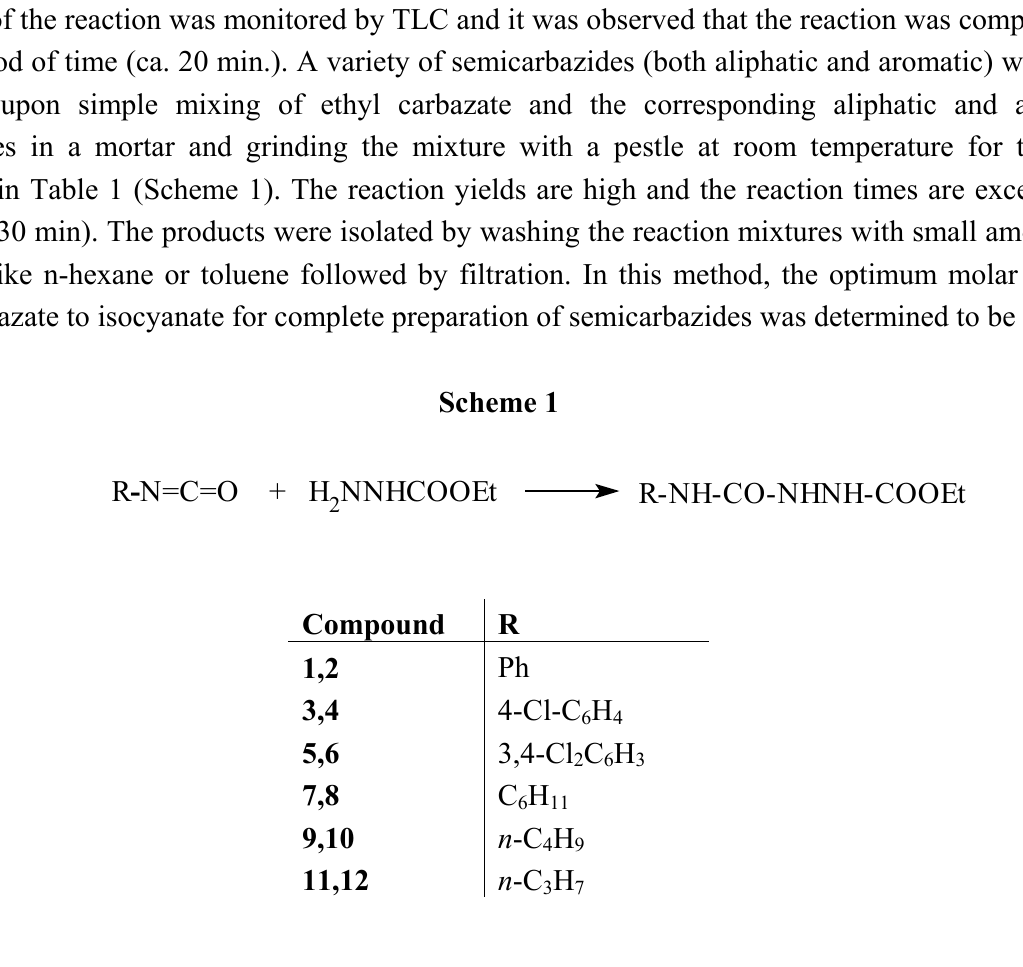
Table 1. Solid-state synthesis of 1-ethoxycarbonyl-4-substituted-semicarbazides